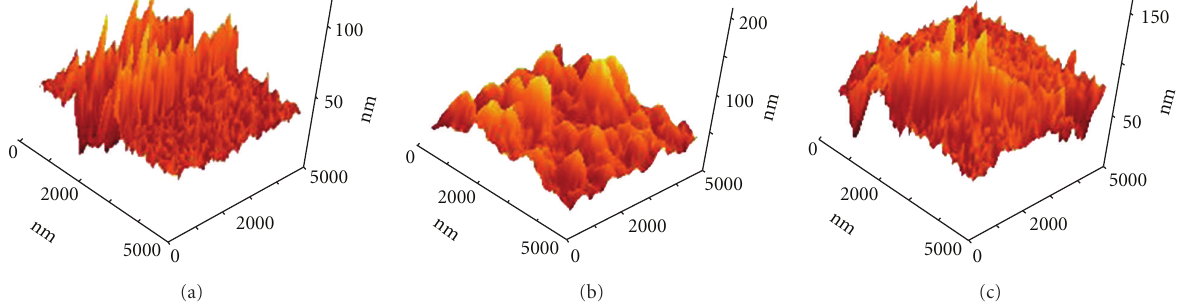
Figure 3: AFM analysis of ZnO films deposited on PET substrates with di ff erent thicknesses.